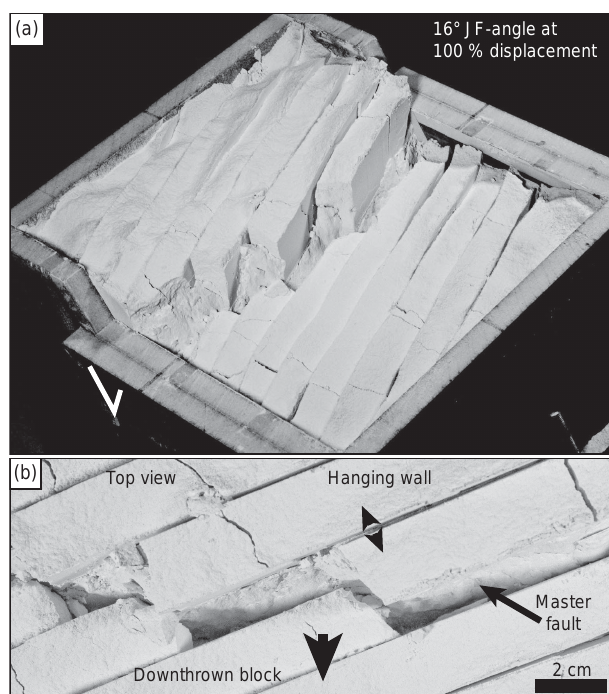
Figure 3. (a) Oblique view of the 16 ◦ JF-angle showing defor- mation localized at pre-existing joints and step-over structures. (b) Top-view photograph of the same experiment shows the typi- cal zigzag shape formed by step-overs at the master